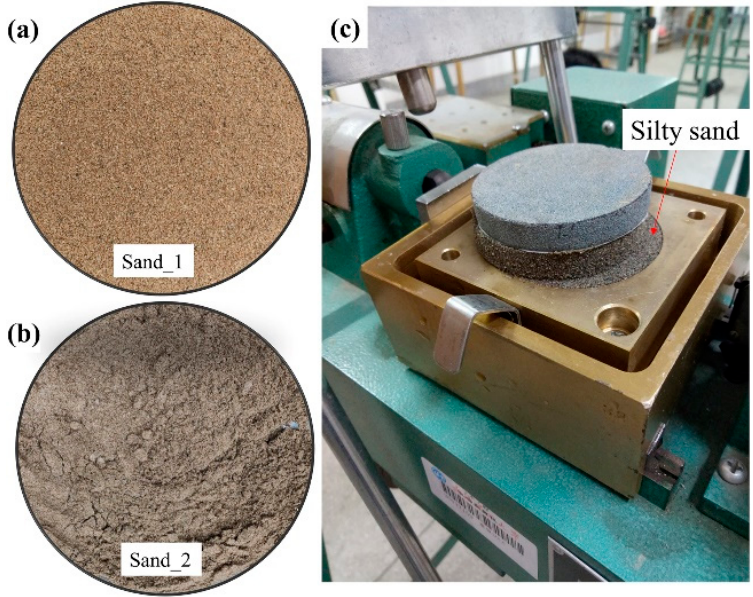
Figure 3. Sand samples and laboratory direct shear test: ( a ) Sand_1; ( b ) Sand_2; ( c ) Laboratory direct shear test.